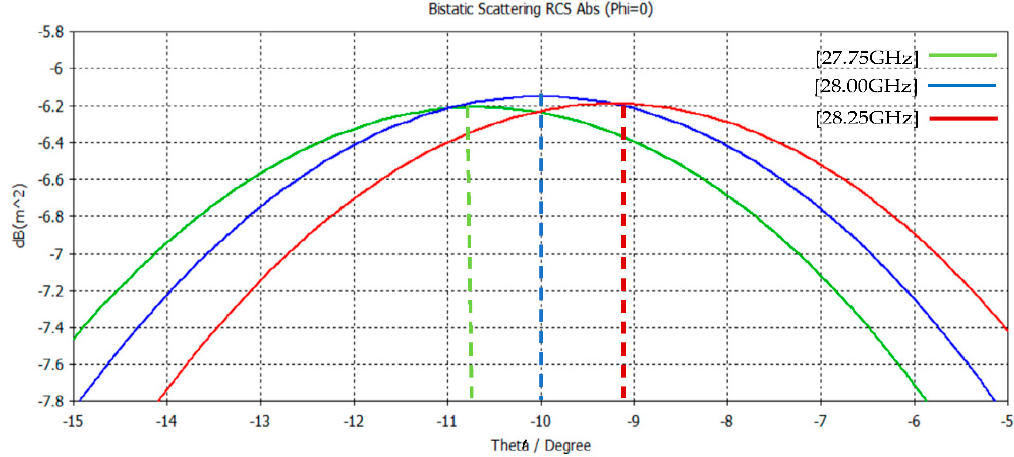
Figure 10. Results of bandwidth for beam steering 10° at 28 GHz in the three-stripe configuration.